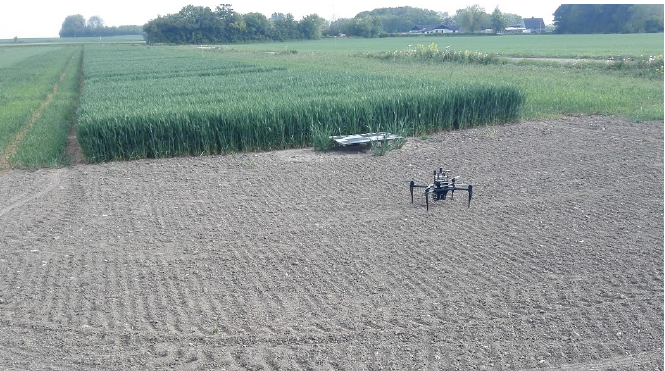
Figure 1. unmanned aerial vehicle (UAV) and experimental field on the day of data recording. A Matrice 100 UAV platform from DJI [32] was